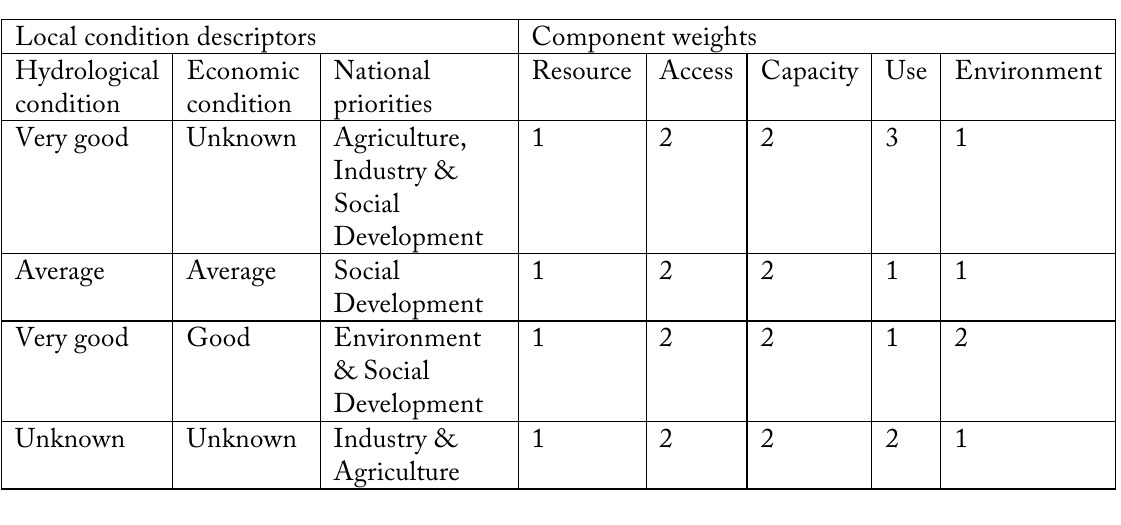
Table 7 Weighting options for the